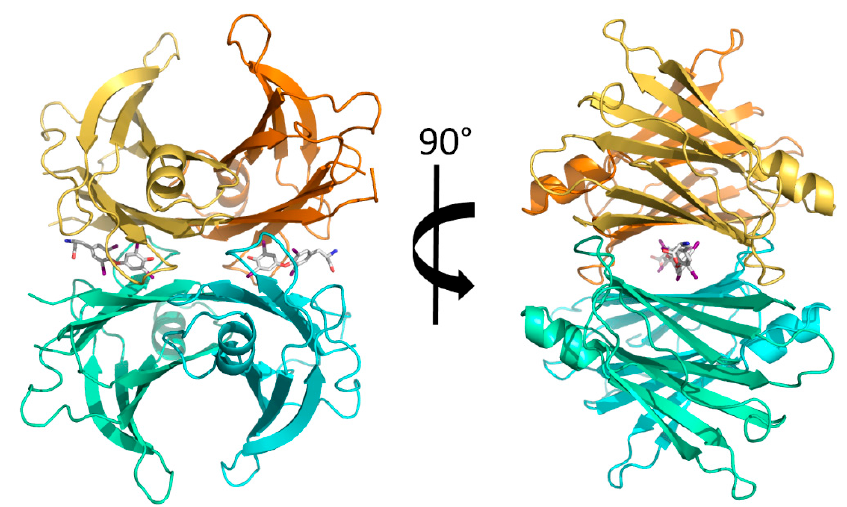
Figure 1. Crystal structure of transthyretin (TTR) bound to the natural ligand thyroxine (T4, PDB ID: 2ROX). The functional TTR homotetramer is assembled by two TTR dimers, AB in orange and A’B’ in cyan.